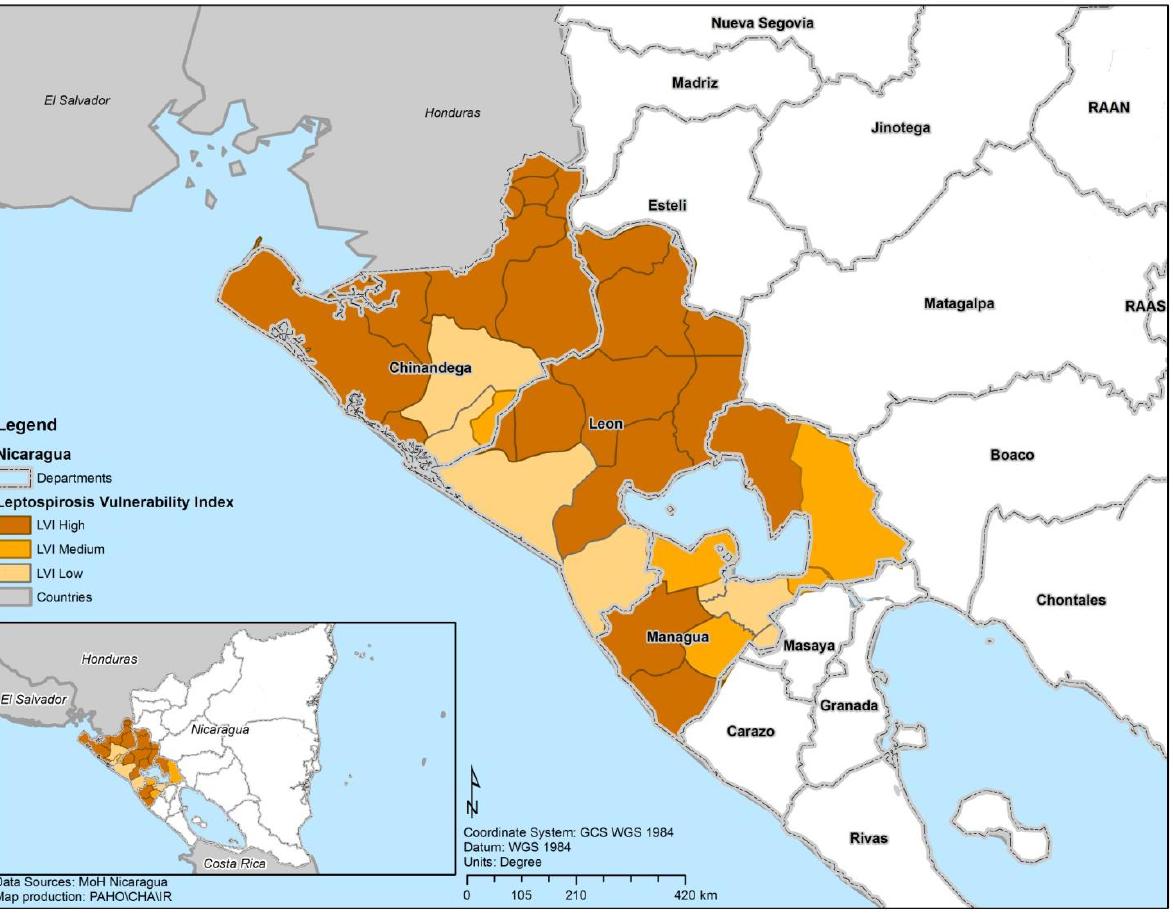
Figure 3. Municipalities of Chinandega, Leon, and Managua according to the local vulnerability index